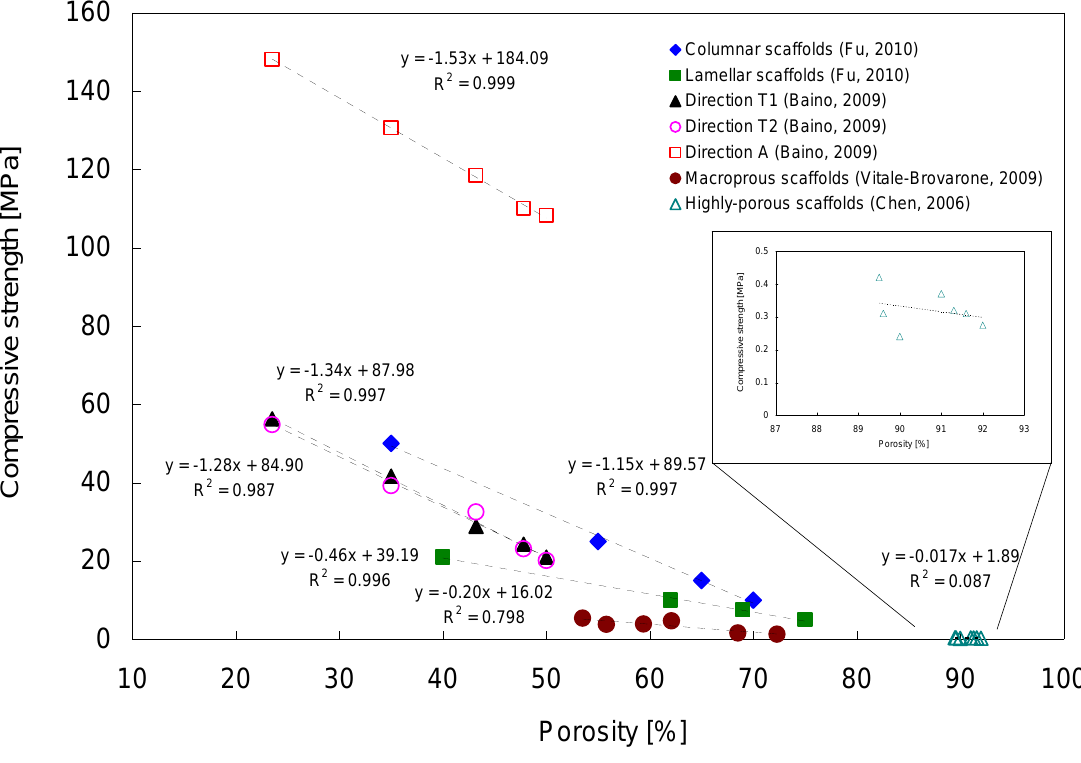
Figure 7. Relationship between porosity and compressive strength of bioactive glass-ceramic scaffolds. Data adapted from refs.